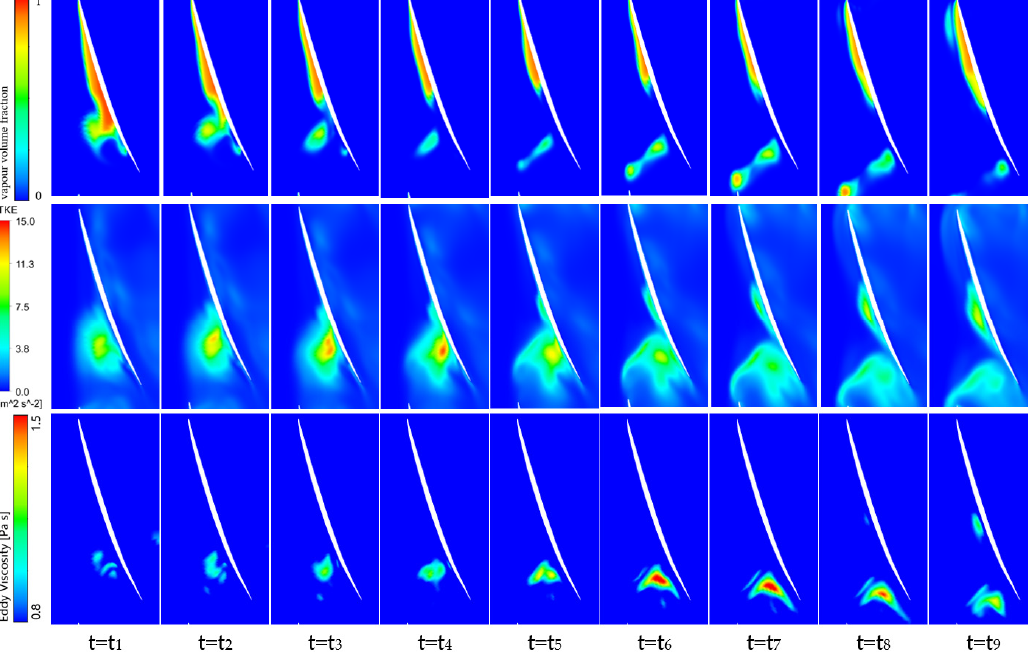
Figure 10. Span = 0.9 cavitation shedding and the evolution of turbulent kinetic energy.